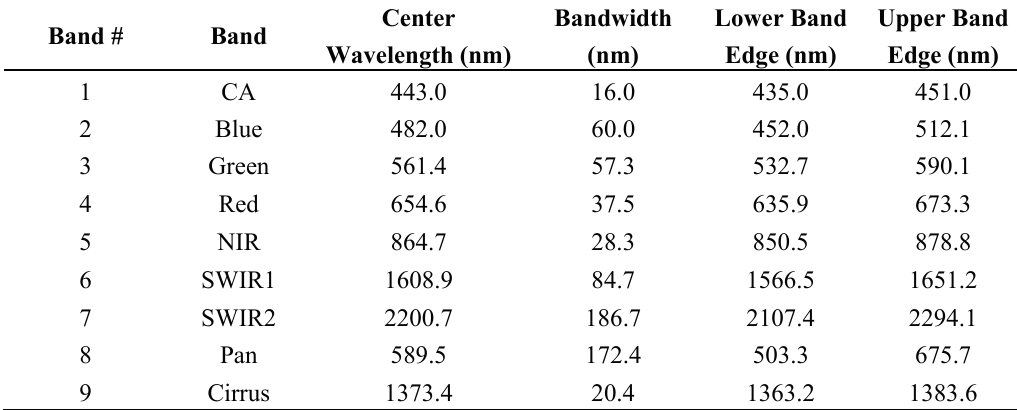
Table 4. Summary of band-average spectral response bandwidths and edges as determined from the full-width, half-maximum for each